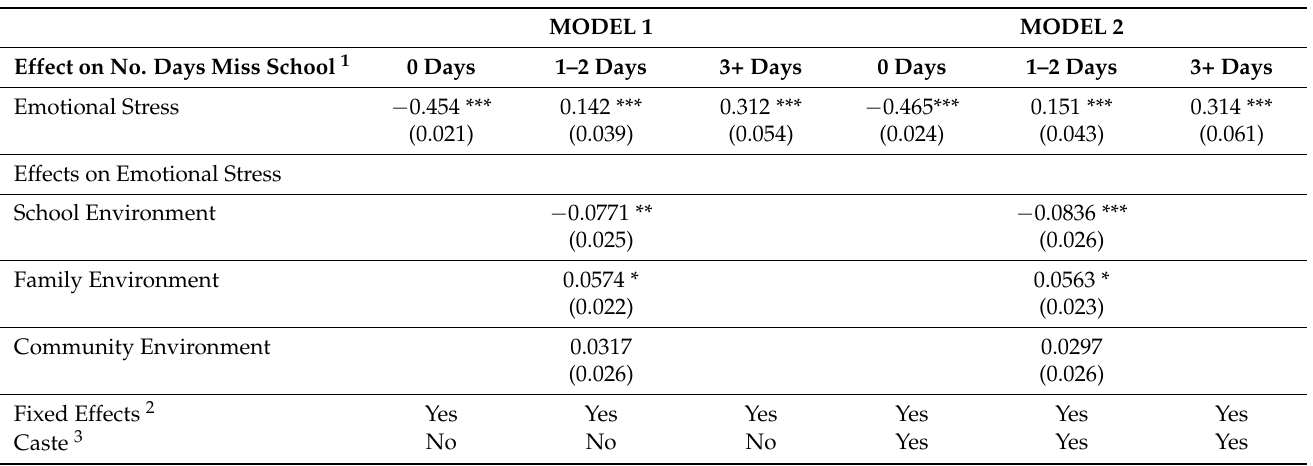
Table 6. Marginal effects of conditioned mixed process (CMP) estimation of menstruation-related emotional stress & school